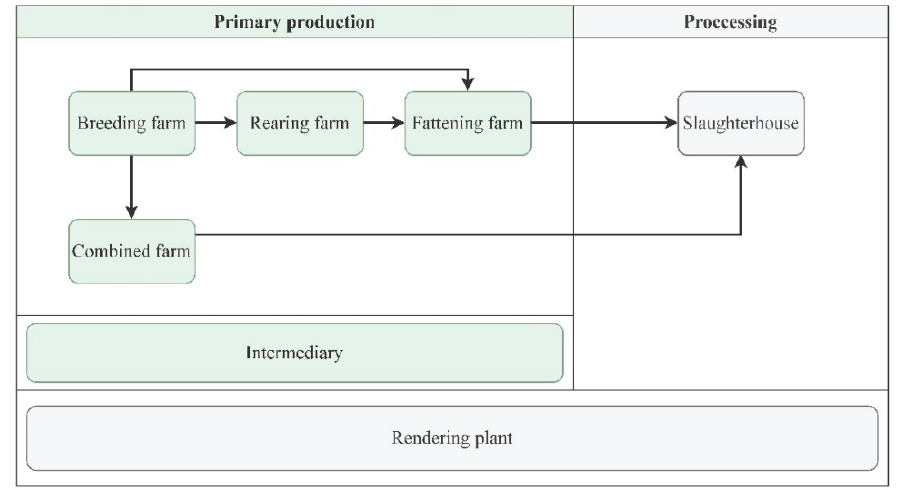
Figure 1. Entities in the simulation model and their relationships.